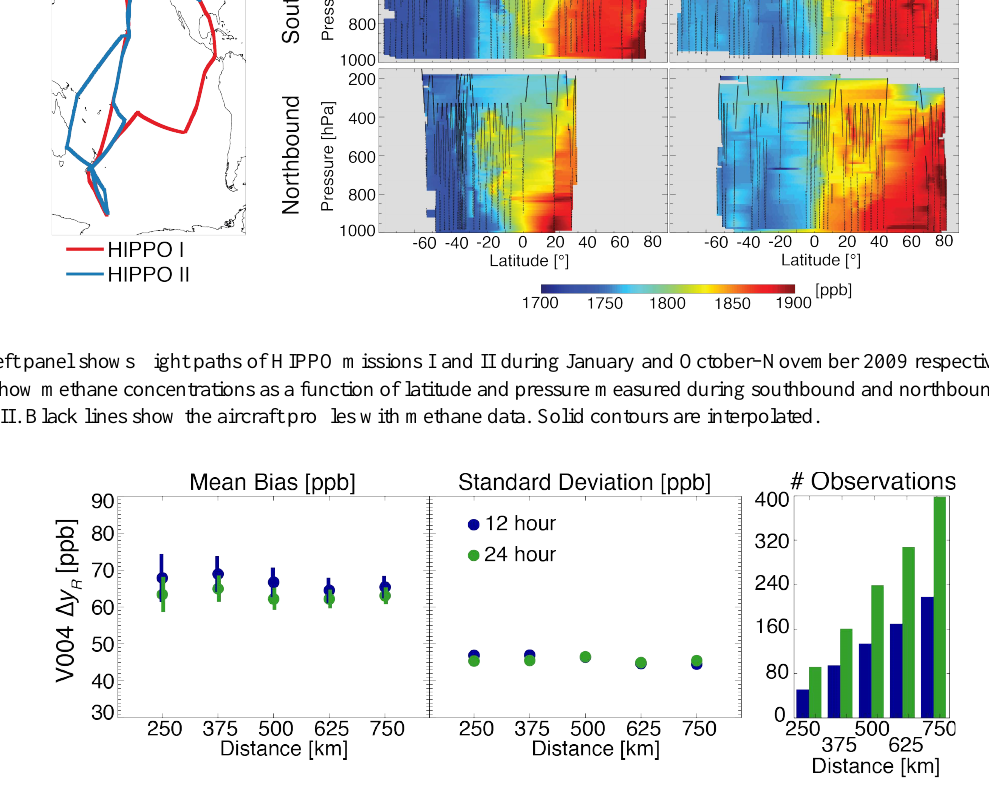
Fig. 3. Error statistics for TES V004 methane plotted as a function of the size of the coincidence window for the HIPPO I and II vertical profiles. Green and blue symbols represent coincident time windows of ± 24h and ± 12h respectively. Values shown are the mean value (mean bias) and residual standard deviation of the difference 1y R between TES and HIPPO representative tropospheric volume mixing ratios (RTVMRs). The numbers of observations in the statistics are shown in the right panel. Error bars in the left panel represent standard errors on our estimates of the mean